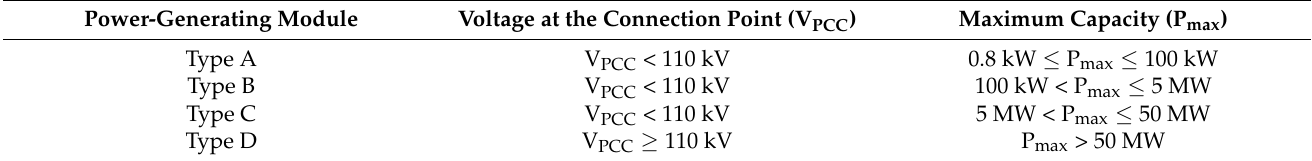
Table 1. Power-generating modules classification in the Spanish grid Code [33]. Power-Generating Module